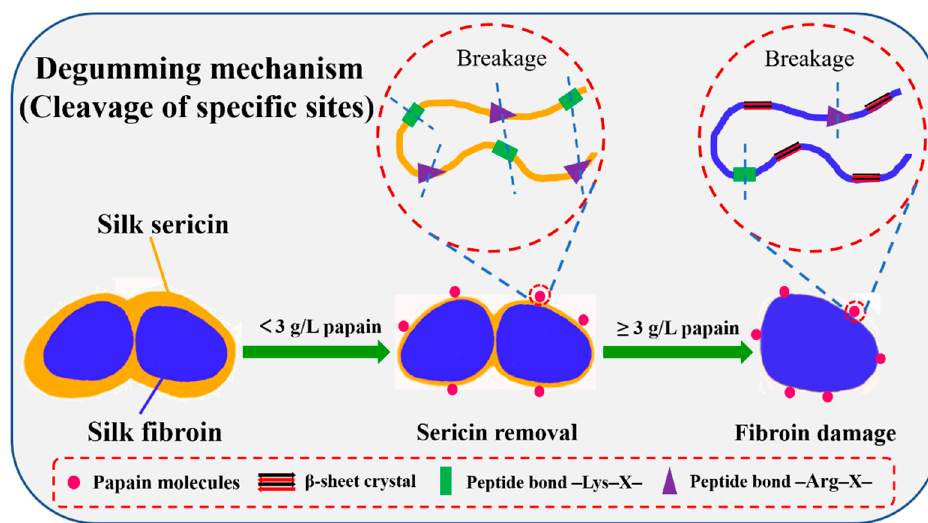
Figure 7. Underlying degumming mechanism of papain treatment.